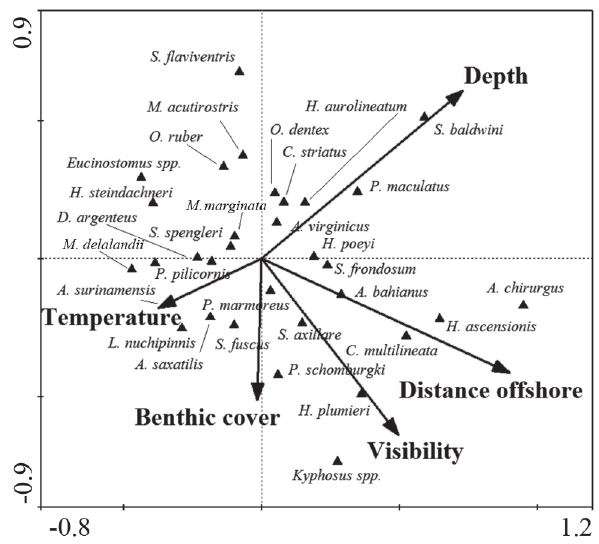
Fig. 6. Canonical Correspondence Analysis (CCA) diagram showing the 31 most abundant fish species (> 0.45% total abundance) and environmental variables